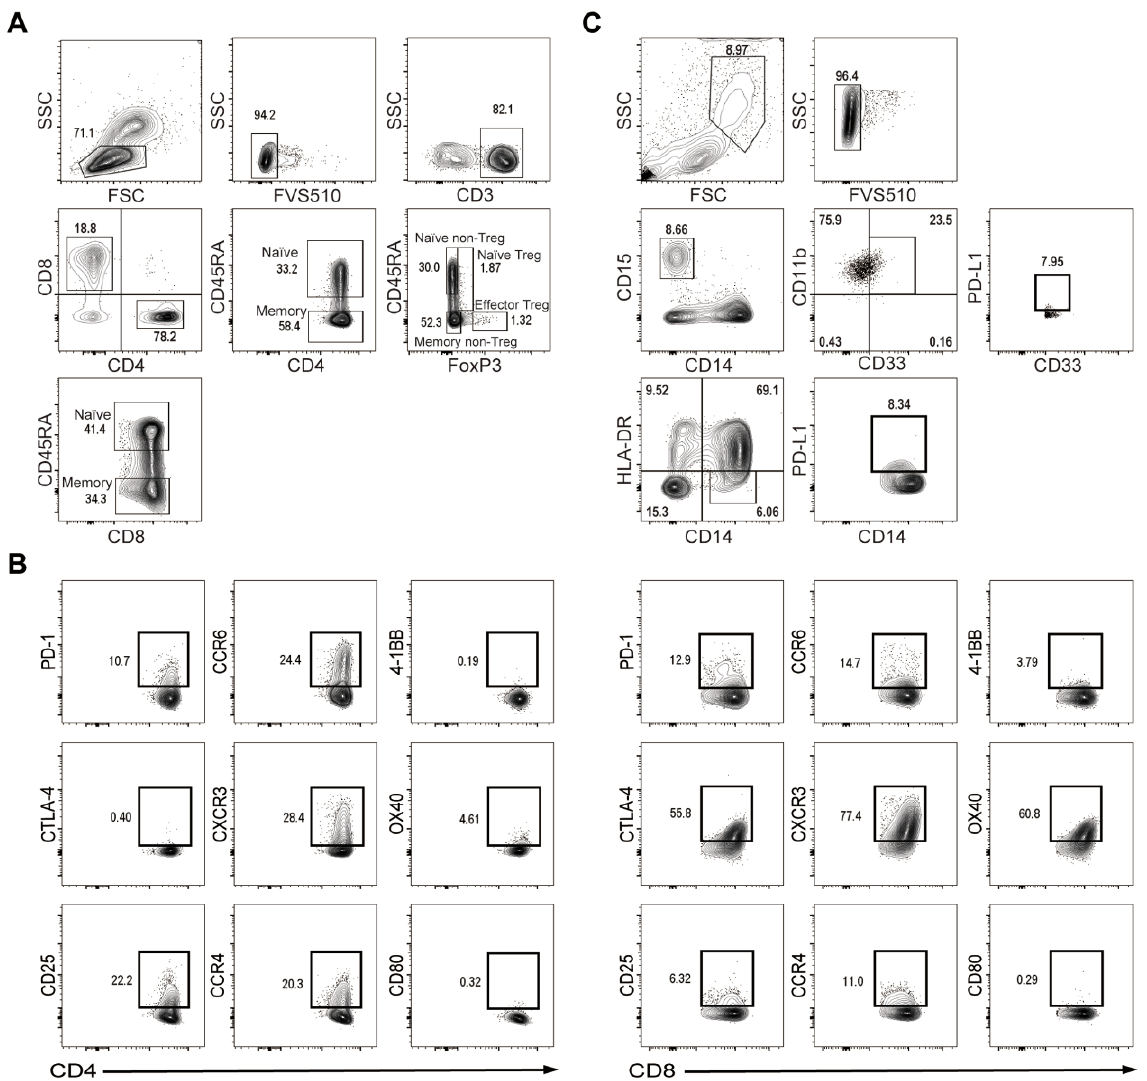
Figure 2. Peripheral blood T cell and MDSC profiles. ( A ) Flow cytometry analysis of CD4+ and CD8+ T cells. Subpopulations of CD8+ T cells were defined by the expression of CD45RA: naïve CD8+ T cells (CD8+CD45RA+) and memory CD8+ T cells (CD8+CD45RA-), and subpopulations of